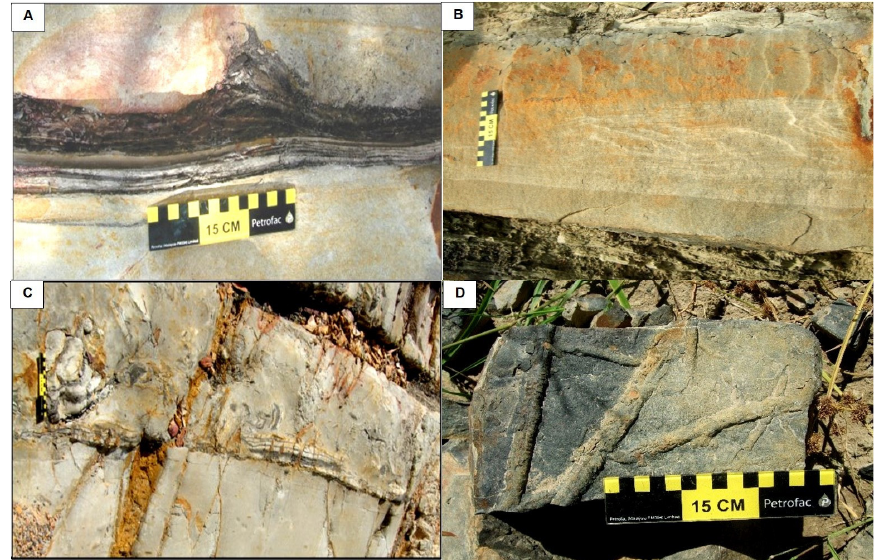
Figure 3. Examples of sedimentary structures in the Crocker Formation. ( a ) Flame structure found in L1. ( b ) Complete Bouma sequence from Ta to Tf found in L3. ( c ) Rip-up mud clasts in L2. ( d ) Cruziana sp. of trace fossils in L2.